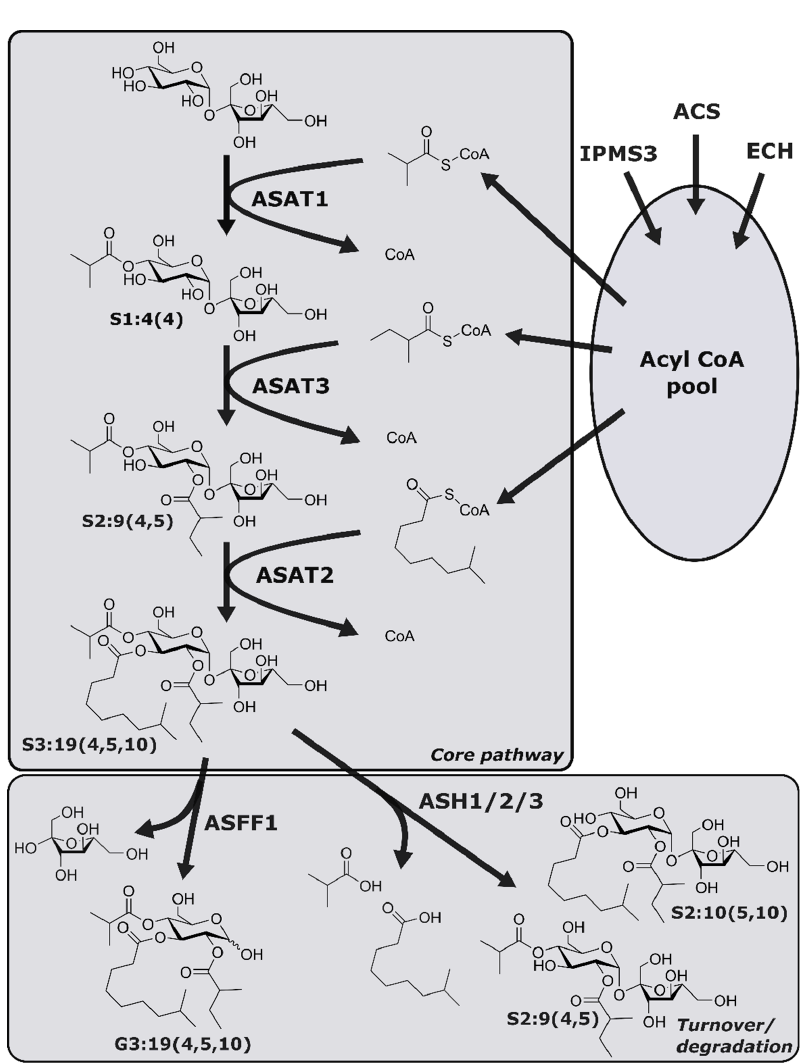
Figure 1. The acylsugar biosynthetic pathway in S. pennellii . Enzymes including acyl CoA synthetase (ACS), enoyl CoA hydratase (ECH), and isopropylmalate synthase 3 (IPMS3) contribute to production of the acyl CoA pool. Acylsugar acyltransferases (ASATs) constitute the core acylsugar pathway and transfer acyl chains from acyl CoA molecules to a sucrose core. ASFF1 and ASHs catalyze acylsugar turnover or degradation by hydrolyzing the fructose moiety of the sugar core and acyl chains, respectively. Acylsugar nomenclature is as follows: the first letter indicates the sugar core (“S” for sucrose, “G” for glucose); the number before the colon indicates the number of acyl chains; the number after the colon indicates the sum of carbons in all acyl chains; the numbers in parentheses indicate the number of carbons in individual acyl chains. ACS—acyl CoA synthetase; ASAT— acylsucrose acyltransferase; ASFF—acylsucrose fructofuranosidase; ASH—acylsugar hydrolase;